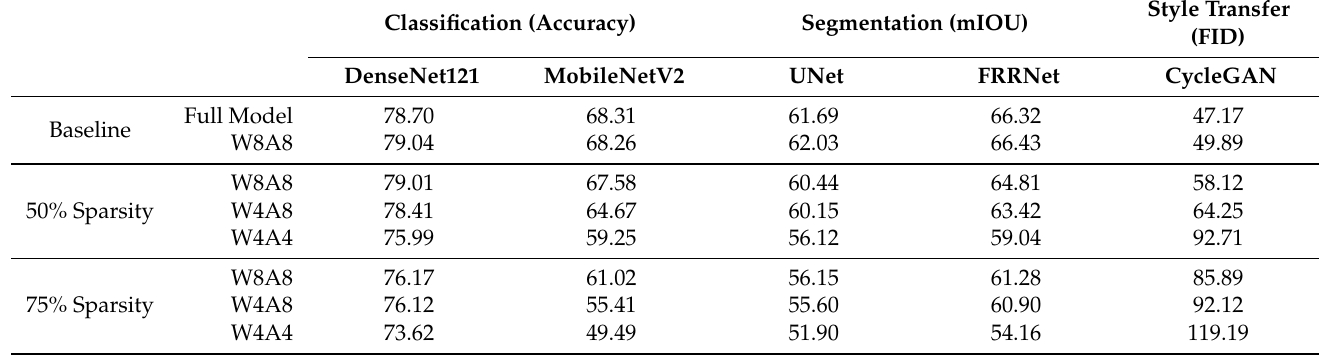
Table 3. Joint channel pruning and uniform quantization to learn low-precision structured subnet- works using our algorithms depicted in Figure 1 and discussed in Section